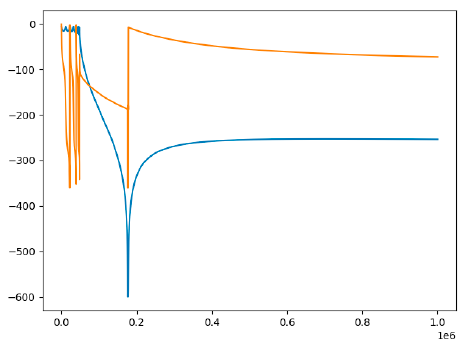
Figure 4. Conventional FRA signature.